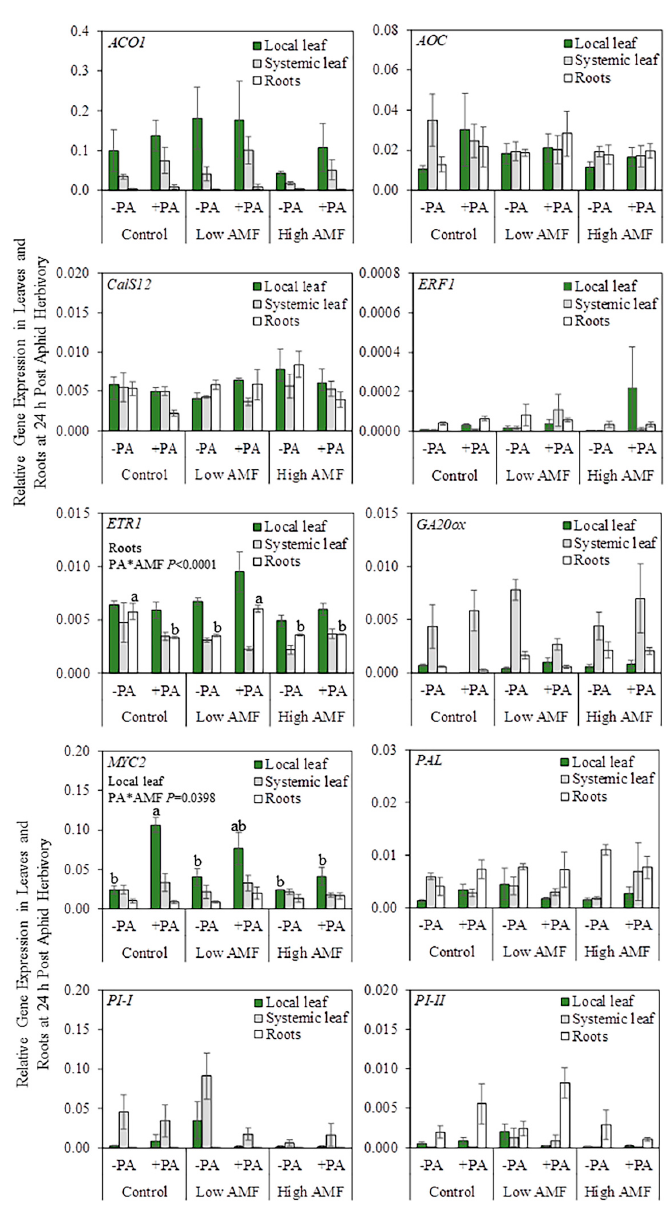
Figure 2. Relative gene expression in local leaf, systemic leaf, and roots after 24 h of herbivory by potato aphids ( Macrosiphum euphorbiae ) on potato plants ( Solanum tuberosum ). Non-infested non-mycorrhizal plants ( − PA Control); potato-aphid-infested non-mycorrhizal plants ( + PA Control); non-infested plants with a low level of AM fungal root colonization ( − PA Low AMF); potato-aphid-infested plants with a low level of AM fungal root colonization ( + PA Low AMF); non-infested plants with a high level of AM fungal root colonization ( − PA High AMF); and potato-aphid-infested plants with a high level of AM fungal root colonization ( + PA High AMF). The only PA*AMF interactions that were significant in the two-factor ANOVA were for ERT1 (roots) and MYC2 (local leaf). One-factor ANOVA followed by the Tukey–Kramer test was used when the interaction term was significant (PA*AMF p ≤ 0.05). Di ff erent letters indicate significant di ff erence among treatments based on the Tukey–Kramer test ( p ≤ 0.05). Values represent the mean ± SEM of three biological replicates and two technical replicates per treatment. The p -values from Table S1 were used to generate this figure. ACO1 = AMINOCYCLOPROPANE-1-CARBOXYLATE OXIDASE 1; AOC = ALLENE OXIDE CYCLASE; CalS12 = CALLOSE SYNTHASE 12; ERF1 = ETHYLENE RESPONSE FACTOR 1; ETR1 = ETHYLENE RECEPTOR 1; GA20ox = GIBBERELIC ACID 20-OXIDASE; MYC2 = BASIC-HELIX-LOOP-HELIX TRANSCRIPTION FACTOR; PAL = PHENYLALANINE AMMONIA LYASE; PI-I = POTATO TYPE I PROTEASE INHIBITOR; PI-II = POTATO TYPE II PROTEASE INHIBITOR